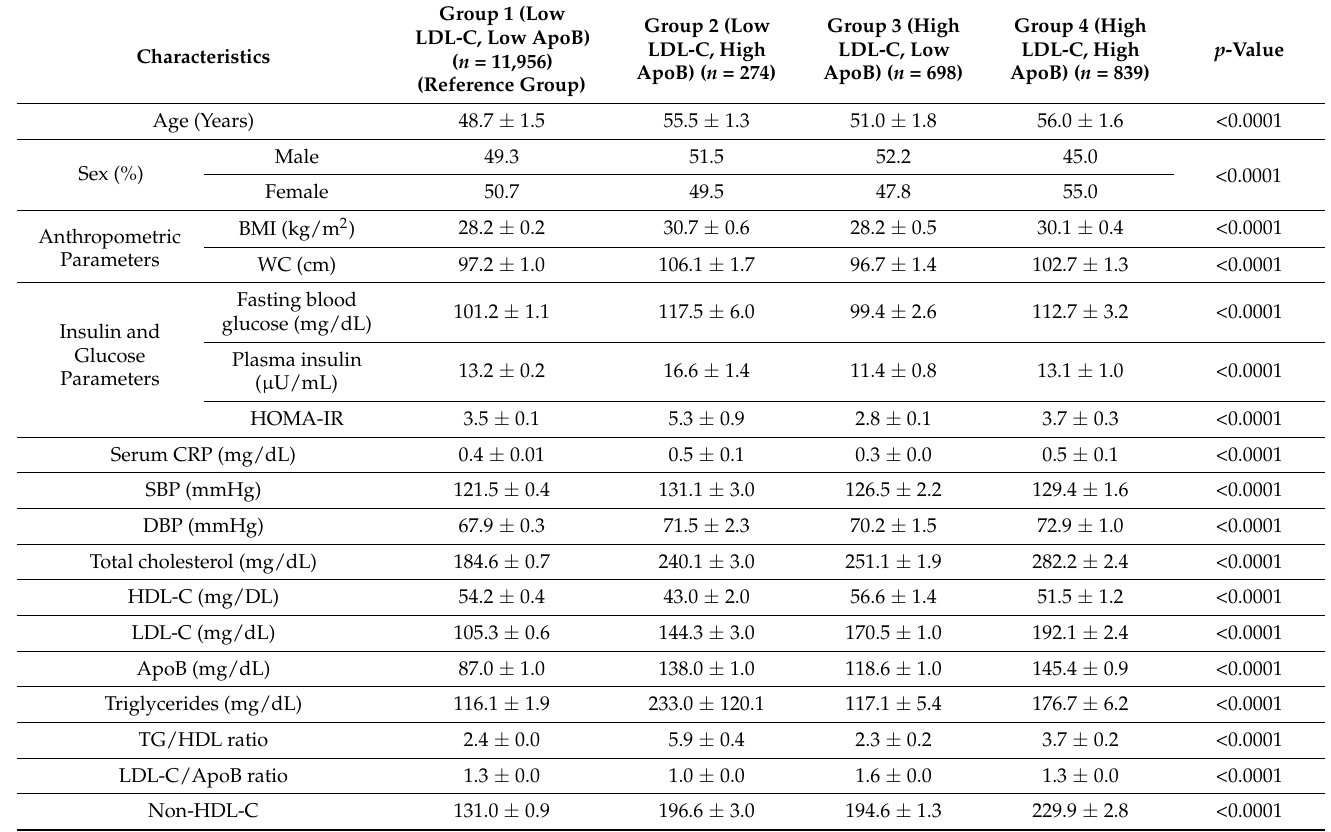
Table 1. Demographic and clinical characteristics of the total population based on LDL-C and ApoB categories.